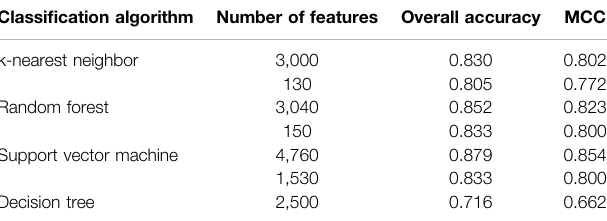
TABLE 2 | Performance of key models for identi fi cation of human protein subcellular locations. Classi fi cation algorithm Number of features Overall accuracy MCC k-nearest